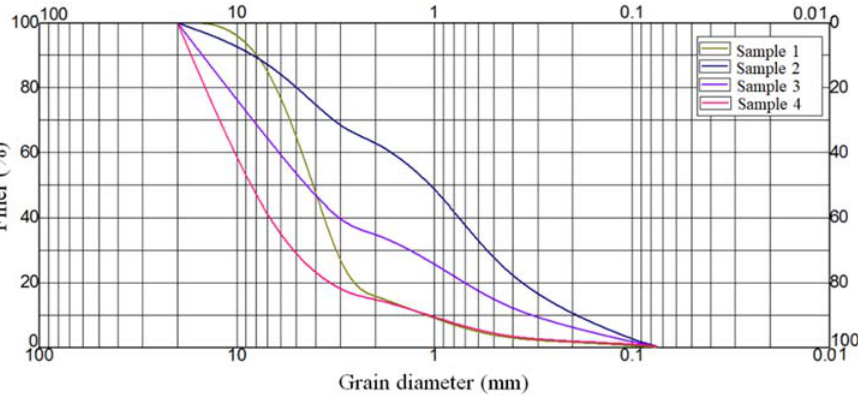
Figure 3. Grain size distribution curve of the fillings (grains from the interlayer soil of ISWZs, which are developed on both sides of the mountains of the Baihetan dam site).